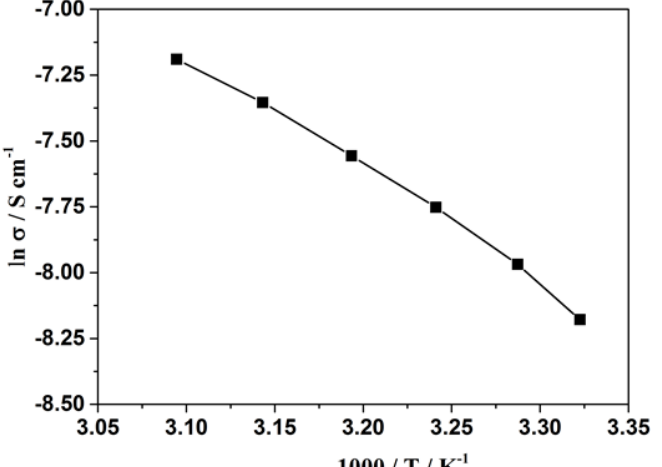
Figure 3: Temperature dependence of the conductivity of the composition, 0.1 PAN:0.4 EC : 0.4 PC : 0.125 MgCl 2 (weight